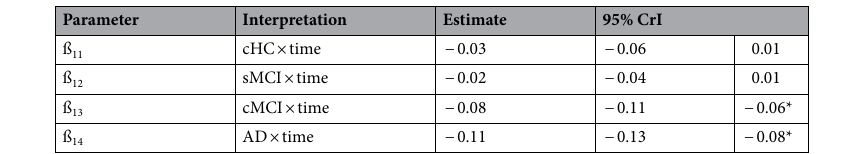
Table 5. Estimation and 95% Credible Intervals (CrI) of the ßs of interest LME model fitted with a Bayesian approach. CrI borders are expressed as the 2.5% and 97.5% percentiles. *Indicates that the effect is significant (i.e., CrI does not contain